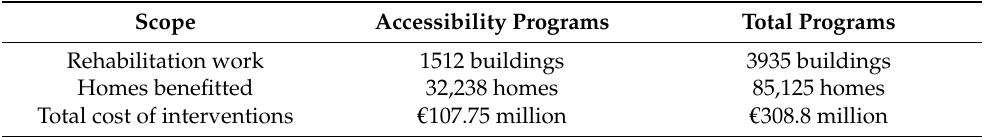
Table 1. Subsidies in residential buildings, 2010–2018.